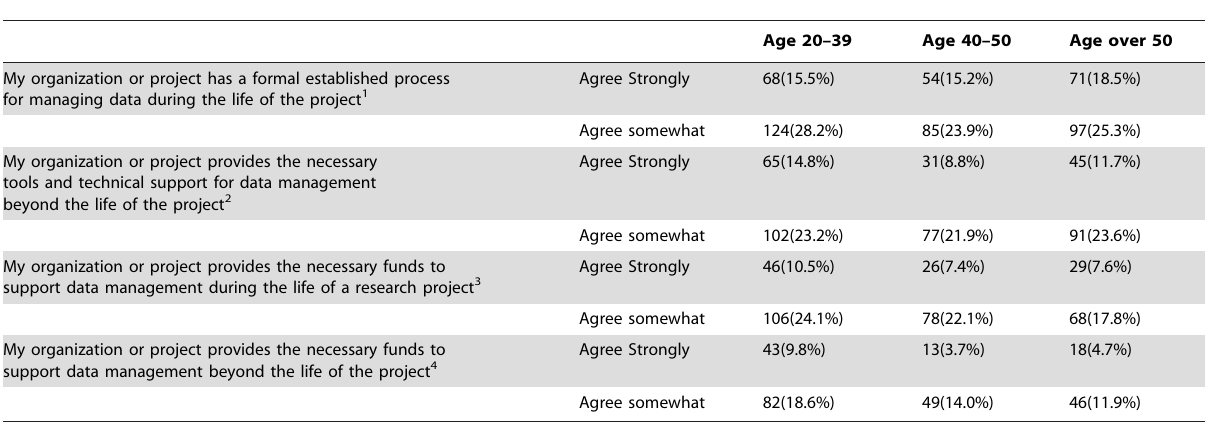
Table 23. Organizational involvement in data issues by age group.